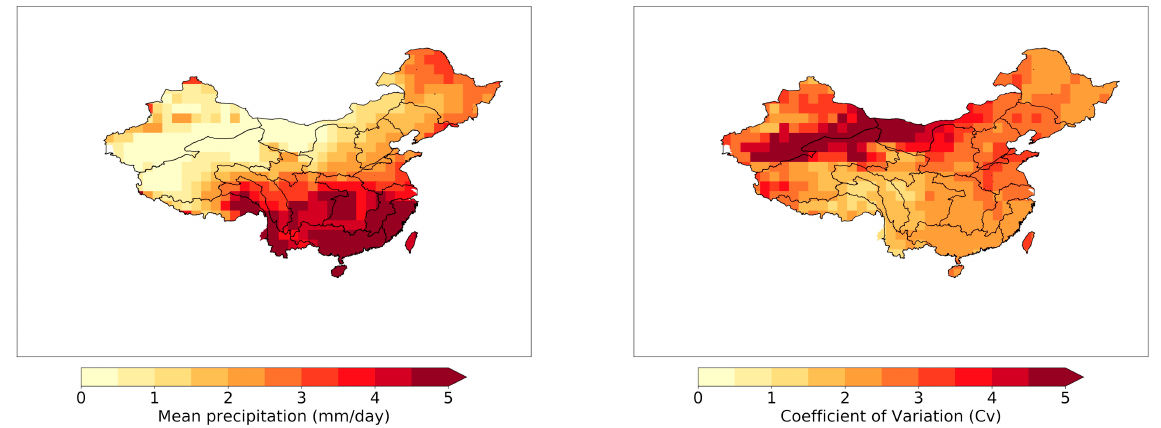
Figure 2. Mean and the coefficient of variation of daily precipitation over China during the boreal summer monsoon.